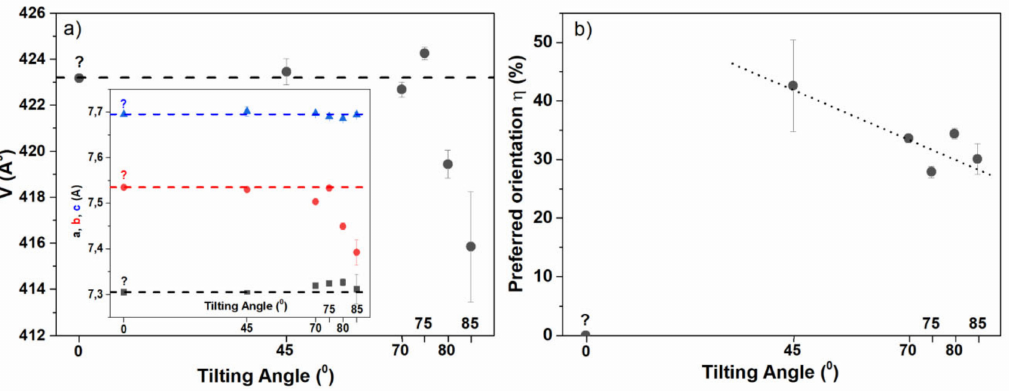
Figure 3. The cell volume V and a , b , c cell constants (presented in the inset) of WO 3 layer ( a ) and degree of preferred grains orientation along (002) direction ( b ). The dashed lines on the graph ( a ) mark the database values of volume and a, b, c constants of the